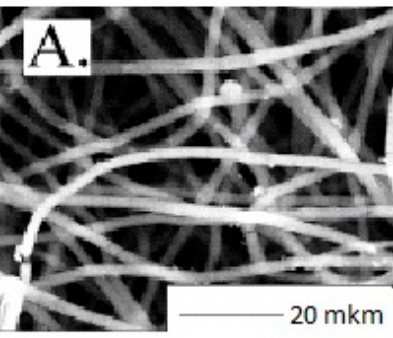
Figure 3. Microphotographs of the non-woven materials based on PHB: ( A ) before and ( B ) after 21 days of hydrolysis in the phosphate buffer solution.